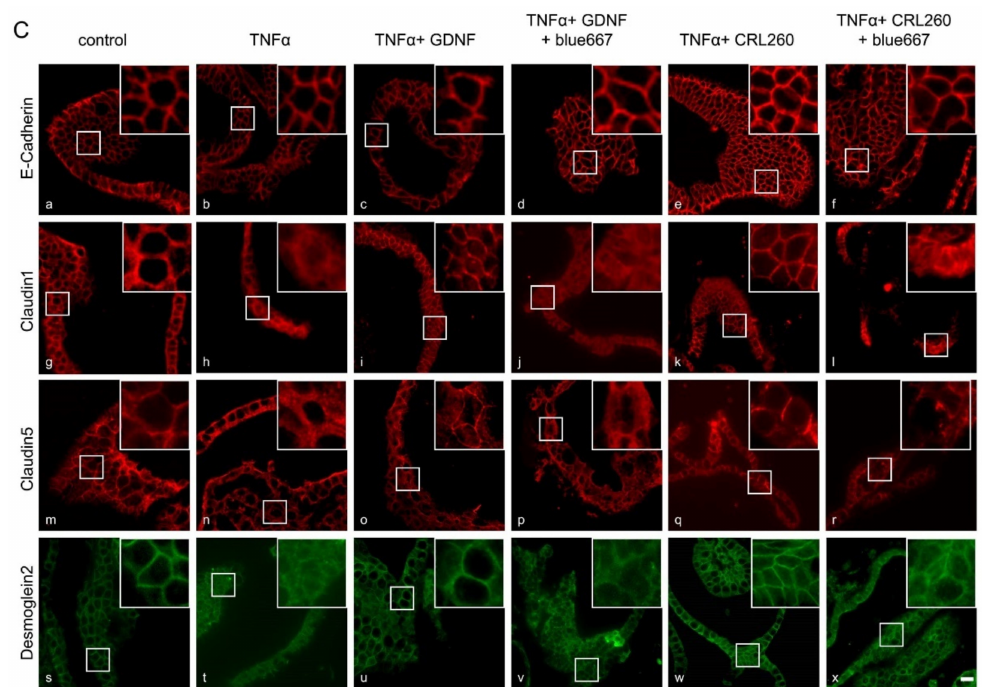
Figure 9. Effects of enteric glial cells (EGC) on organoids after the inflammation-induced breakdown of the intestinal barrier are dependent on RET-mediated pathways. ( A ): Representative images of organoids 1 h after incubation with 4 kDa FITC-Dextran are shown. Compared to controls ( a ) Tumor necrosis factor α (TNF α ) increased the fluorescence inside the organoids ( b ), while simultaneous application of recombinant glial cell line-derived neurotrophic factor (GDNF) ( c ) or EGC supernatants attenuated ( e ) this inflammation-induced breakdown of the intestinal epithelial barrier, while RET inhibitor Blue667 blocked the effects of GDNF and EGC on organoid permeability ( d , f ). (representative figures are shown for n = 7, scale 120 µ m); control = organoids without treatment. ( B ): Permeability in organoids was quantified by the quotient of the fluorescence in the organoid lumen and outside of the organoid. These measurements revealed an inflammation-induced increase to 1.94 ± 0.09-fold of controls. Incubation with GDNF or EGC supernatants reduced the effects of TNF α and the permeability quotient was reduced to 1.11 ± 0.08-fold of controls. This protective effect of EGC supernatants was blunted by concurrent application of Blue667, where the permeability quotient increased again to 2.04 ± 0.07-fold of controls ( n = 7; * = p < 0.05; One-way ANOVA); control = organoids without treatment. ( C ): Representative immunostaining for junctional proteins Desmoglein2 (Dsg2), E-Cadherin, Claudin1 and 5 are shown. TNF α reduced the staining pattern of the tight junction proteins Claudin1 and 5 as well as the staining of Dsg2 at the cell borders ( b , h , n , t ). This effect was attenuated when organoid cells were cultivated with recombinant GDNF and EGC supernatants ( c , i , o , u and e , k , q , w ). The beneficial effects of EGC supernatants were blocked by RET Inhibitor Blue667 ( d , j , p , v and f , l , r , x ) (representatives are shown for n = 6, Scale bar = 80 µ m); control = organoids without treatment ( a , g , m , s